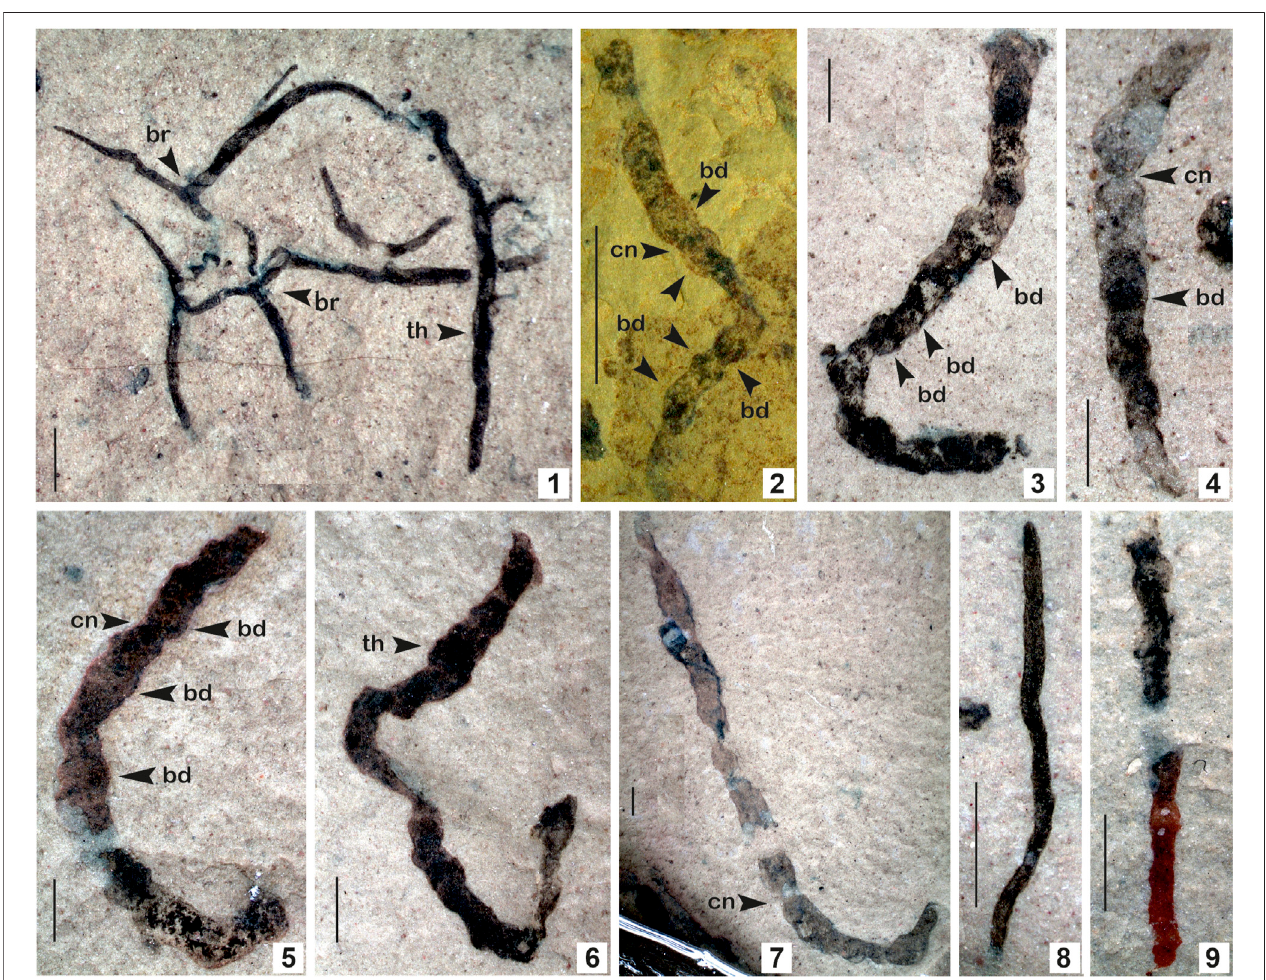
FIGURE 6 | 1. Eoholynia corumbensis Gaucher et al., 2003; 2 – 7. Jiuqunaoella sergeevii n. sp.; 8 – 9 . Synocylindra yunnanensis Chen and Erdtmann, 1991. (Arrow indicates the prominent features: br. branching; bd. bead; cn. constriction; th. thallus). 1. Specimen no. BSIP 42028; 2. Specimen no. BSIP 39782; 3. Specimen no. BSIP42032;4.Specimenno.BSIP41898;5.Specimenno.BSIP42029;6.Specimenno.BSIP42035;7.Specimenno.BSIP42027;8.Specimensno.BSIP42037;9. Specimens no. BSIP 42041. Specimens 1, 3-9 from the Bendla Dongar section and 2 from the Surangi River section. Scale bar is 1.0 mm for each